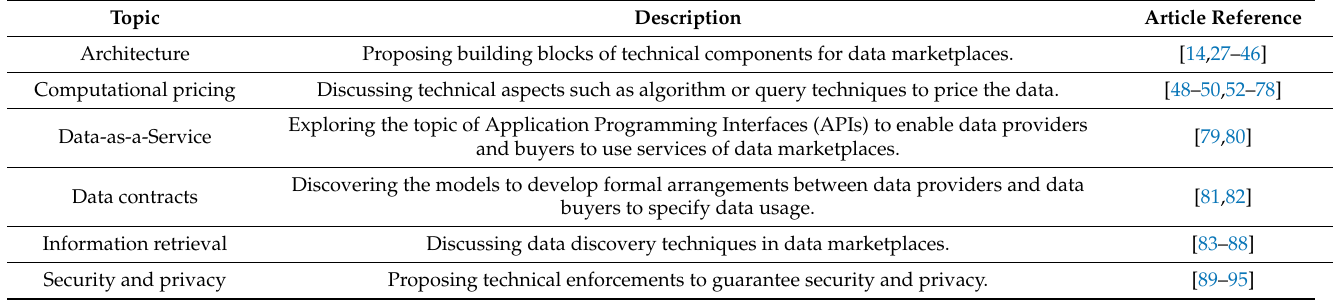
Table 3. The technical